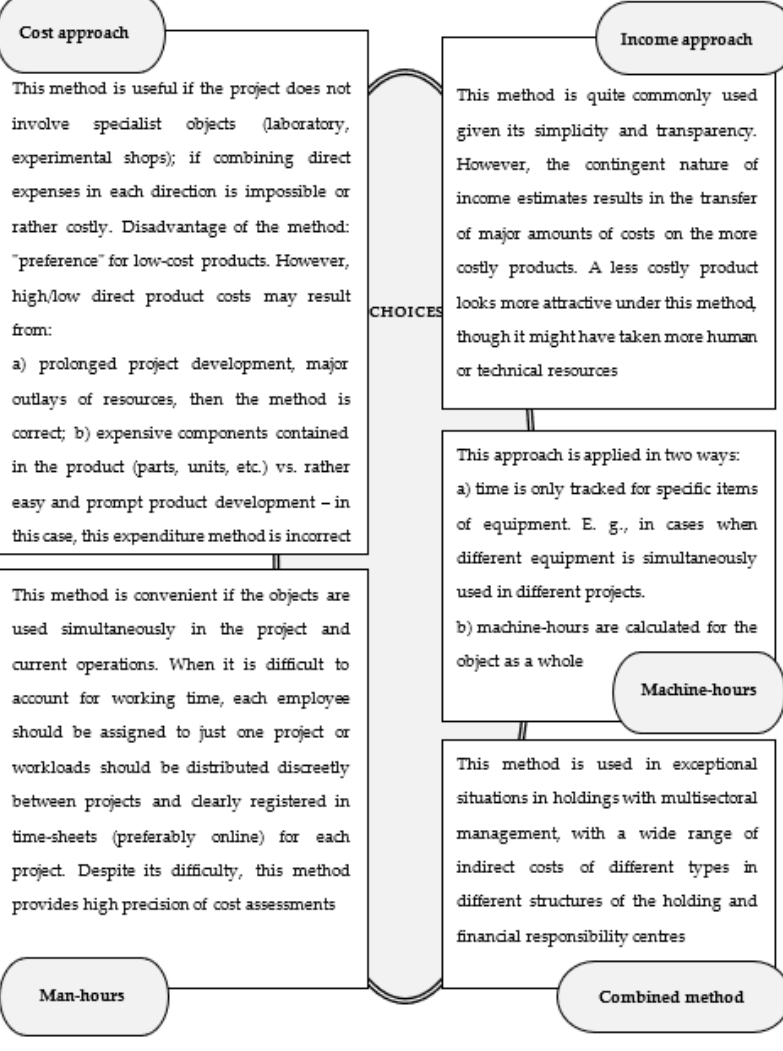
Figure 4. Options for choosing methods for allocating indirect costs in the implementation of innovative projects.